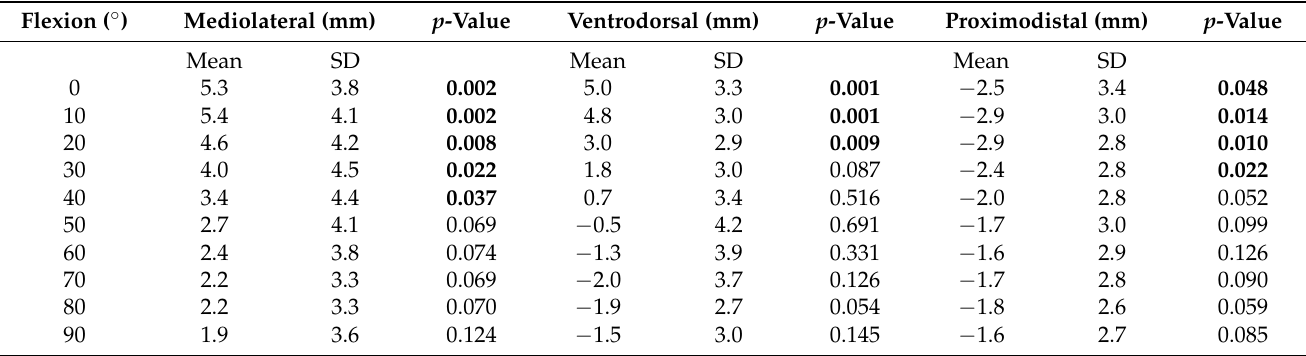
Table 2. Relative shift in the lateral epicondyle after total knee arthroplasty (TKA). Relative shifts in the lateral epicondyle (mediolaterally, ventrodorsally, and proximodistally) after TKA are shown in millimetres (means with standard deviations (SD)) every 10 ◦ of flexion. Positive values show a lateral, dorsal, and distal shift in the epicondyle. Bold characters mark significant differences ( p <